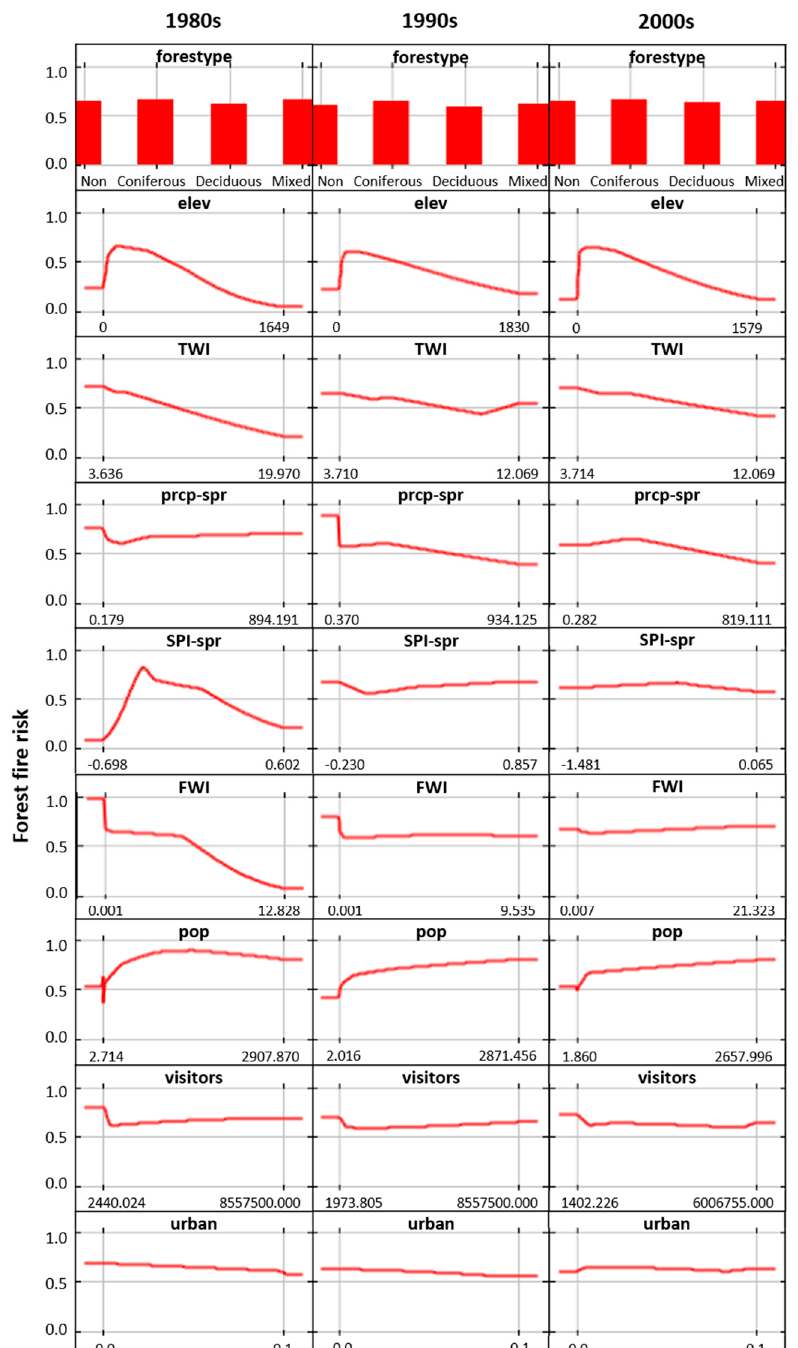
Figure 7. Response curves illustrating the relationship between forest fire probability and the input variables during the 1980s, 1990s, and 2000s (Maxent analysis).